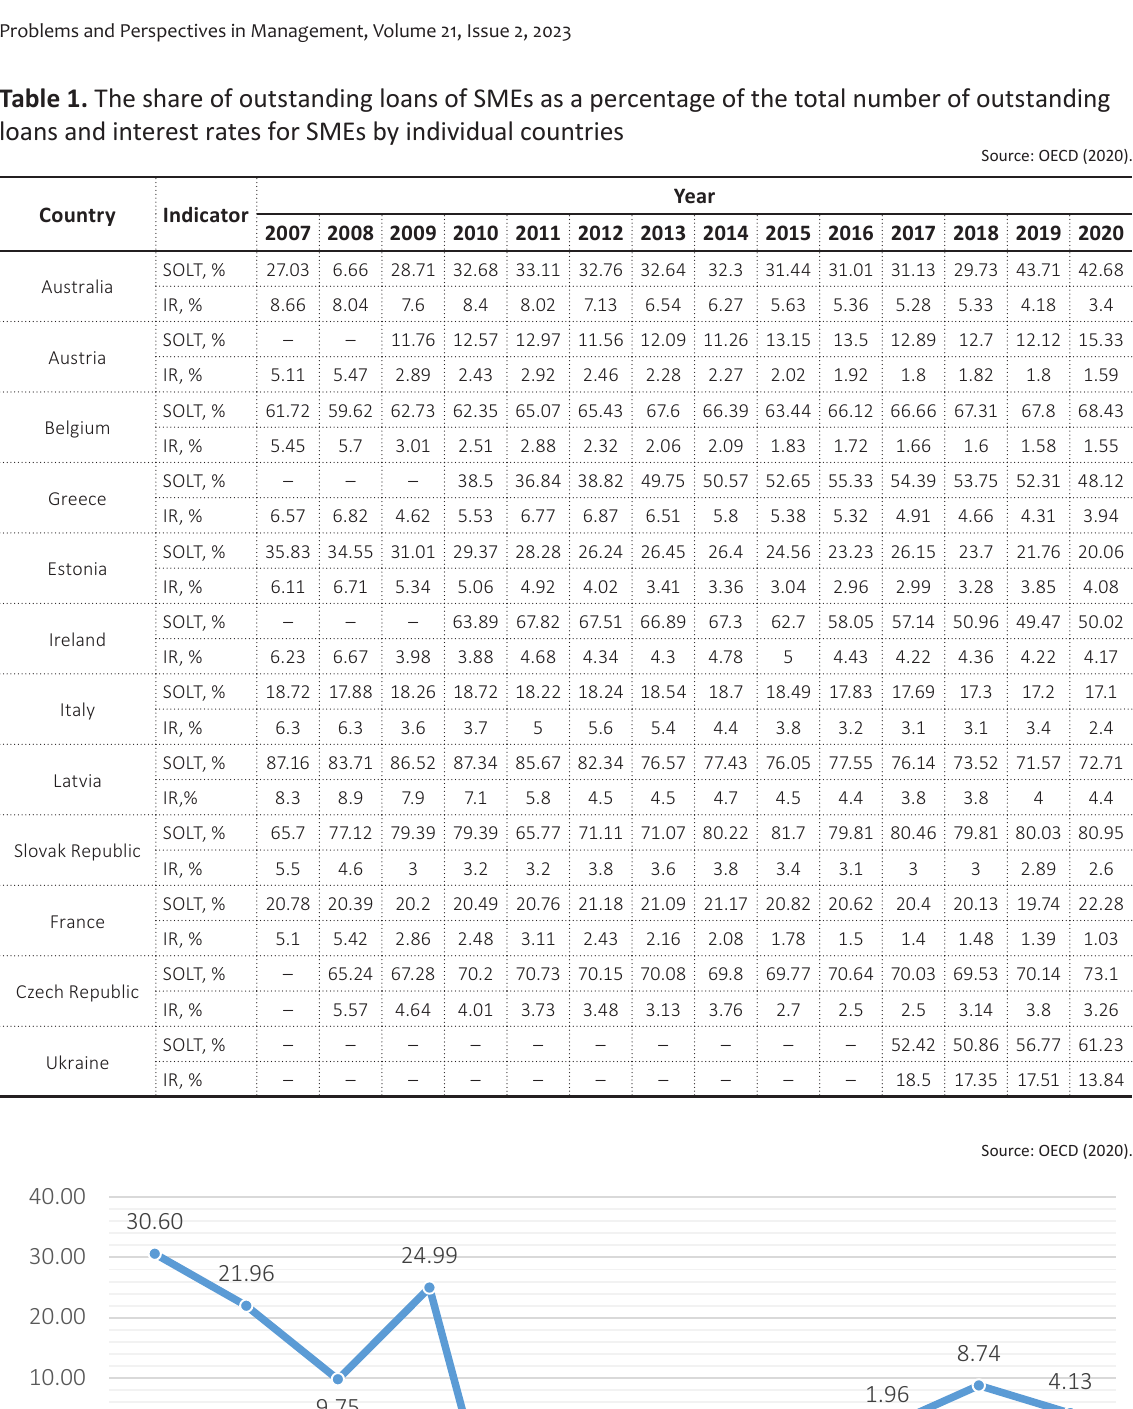
Table 1. The share of outstanding loans of SMEs as a percentage of the total number of outstanding loans and interest rates for SMEs by individual countries